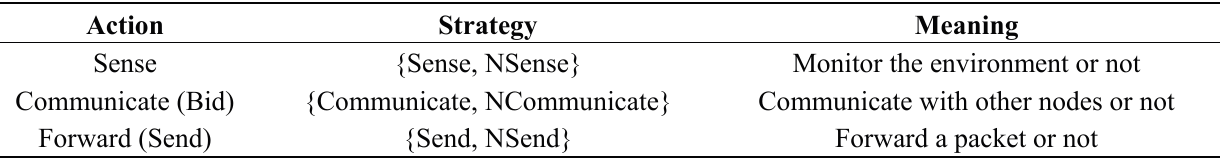
Table 1. The action strategies of a